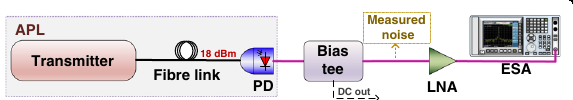
Fig. 12 Set-up used to measure the noise level. PD, photodiode; ESA, electrical spectrum analyzer. The APL consists of a transmitter, fi bre link and a PD. For noise-optimized APLs, the input optical power to the PD is set to its maximum value of 18 dBm. For noise level measurement, there is no RF input power to the transmitter, causing the received signal to be at DC, which is subsequently fi ltered out by the bias tee, leaving only the (AC) noise. This noise is then ampli fi ed